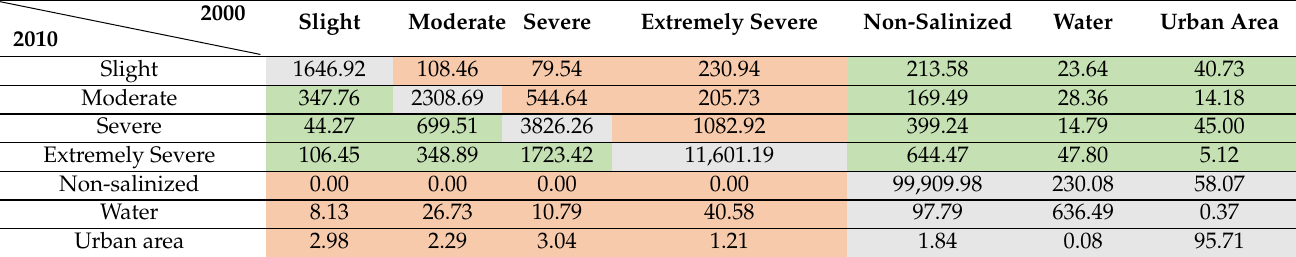
Table 3. Transfer matrix of salinized land from 2000 to 2010 (km 2 ).